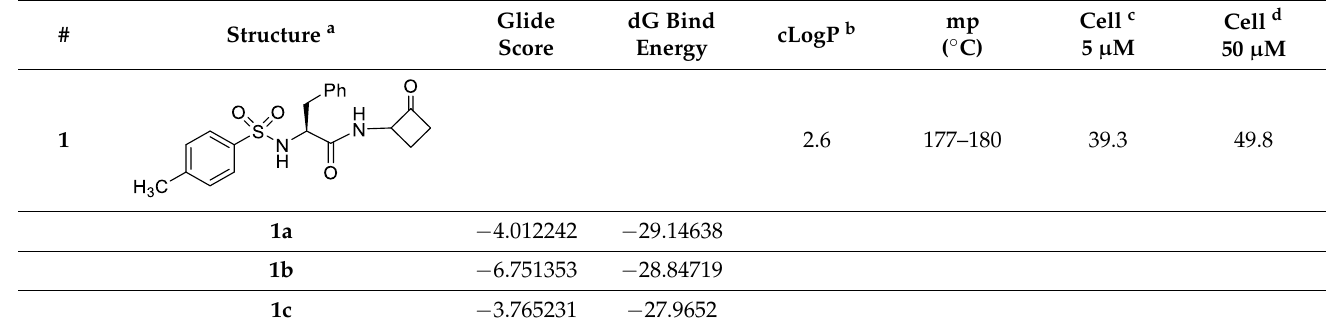
Table 1. Docking parameters and calculated energies of amino acid-derived cyclobutanone hits against SARS-CoV-2 Nsp13 helicase, physicochemical properties, and antiviral cell-based assay results.